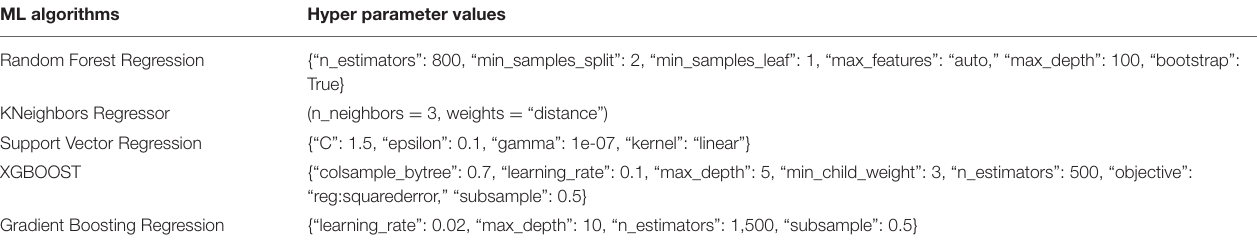
TABLE 4 | Best tuned values of the hyperparameters for the different regression techniques. ML algorithms